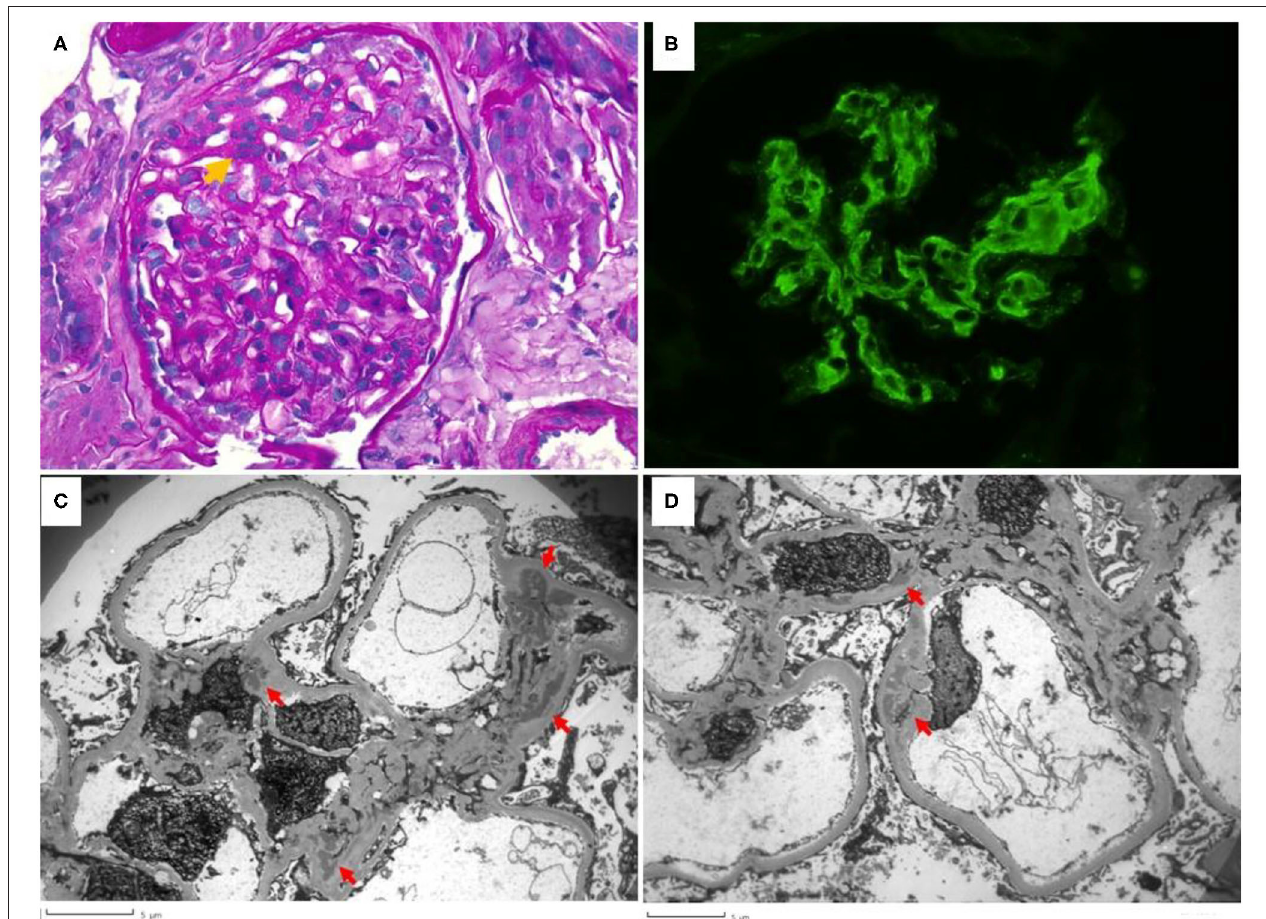
FIGURE 1 | Renal biopsy. (A) shows segmental mesangial hypercellularity (orange arrow) with > 3 mesangial cells in a mesangial area. Peripheral capillaries are patent and no lesions of endocapillary hypercellularity or crescent formation was seen in the biopsy (Periodic Acid Schiff, 400 × magnification). (B) shows the granular mesangial immune complex deposition that stained 2 + for IgG, IgA, C3, C1q, kappa and lambda (IgG is shown, 400 × magnification). (C,D) highlight the electron microscopy findings. Electron dense deposits (red arrows) are present globally in mesangial areas but are not seen to involve the subepithelial or subendothelial distributions. Podocyte foot process effacement is